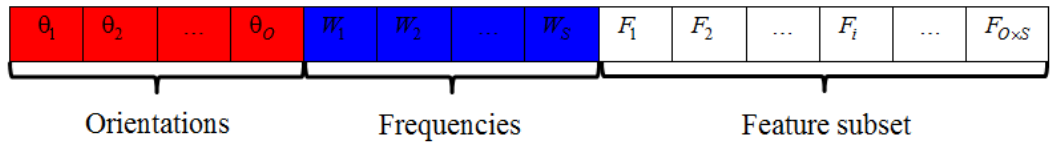
Figure 1. The encoding form of an ant for Gabor